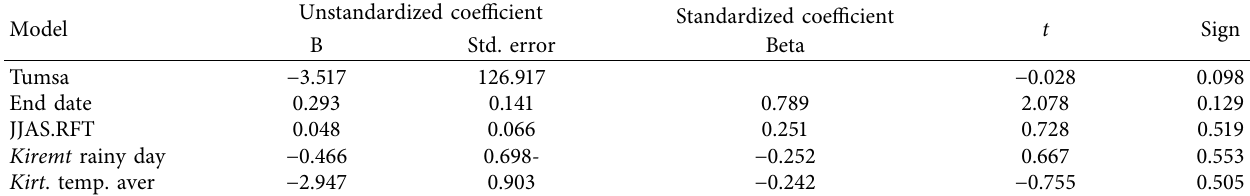
Table 10: Coefficient of regression analysis for rainfall and temperature in the study area.